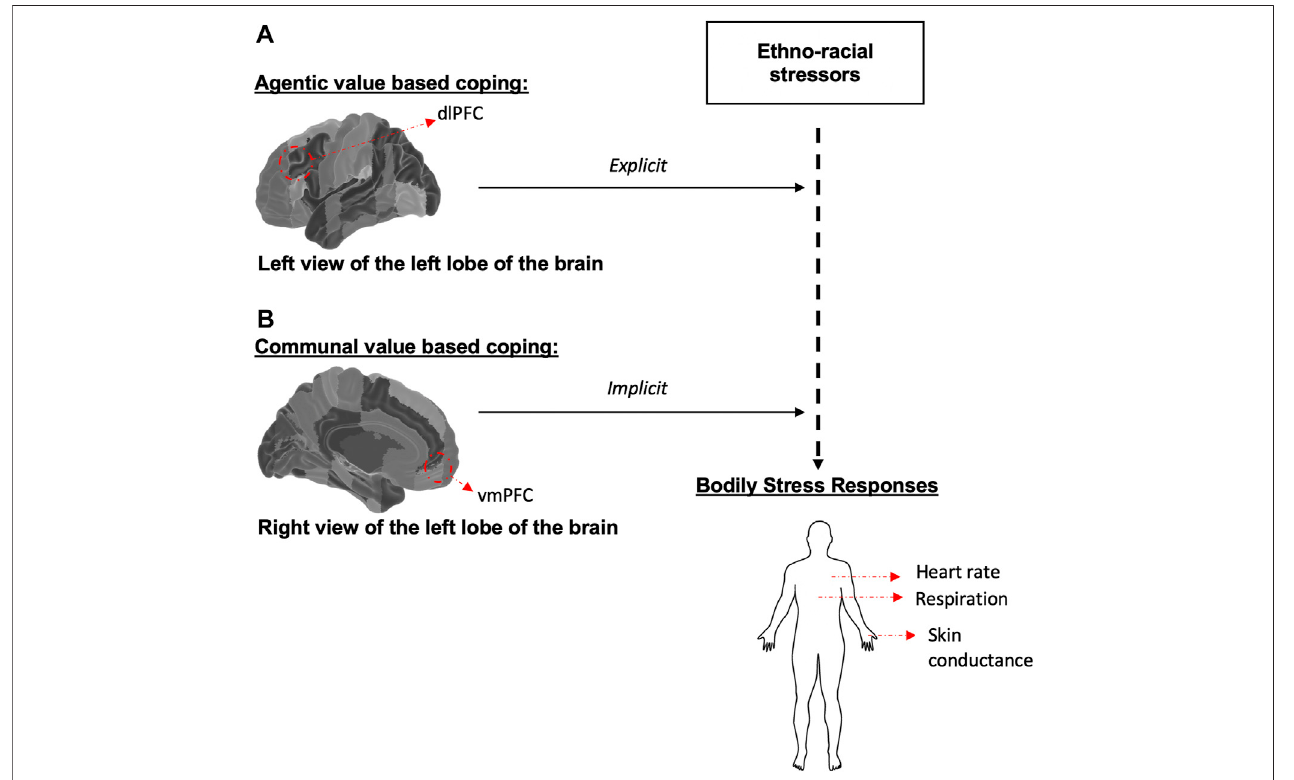
FIGURE 1 | Illustration of the dual processes of value based coping. The brain atlases adapted from the Harvard-Oxford atlas developed at the Center for Morphometric Analysis (CMA), and distributed with the FMRIB Software Library (FSL) (Bakker et al., 2015), 3D Surface View (Majka et al., 2012).